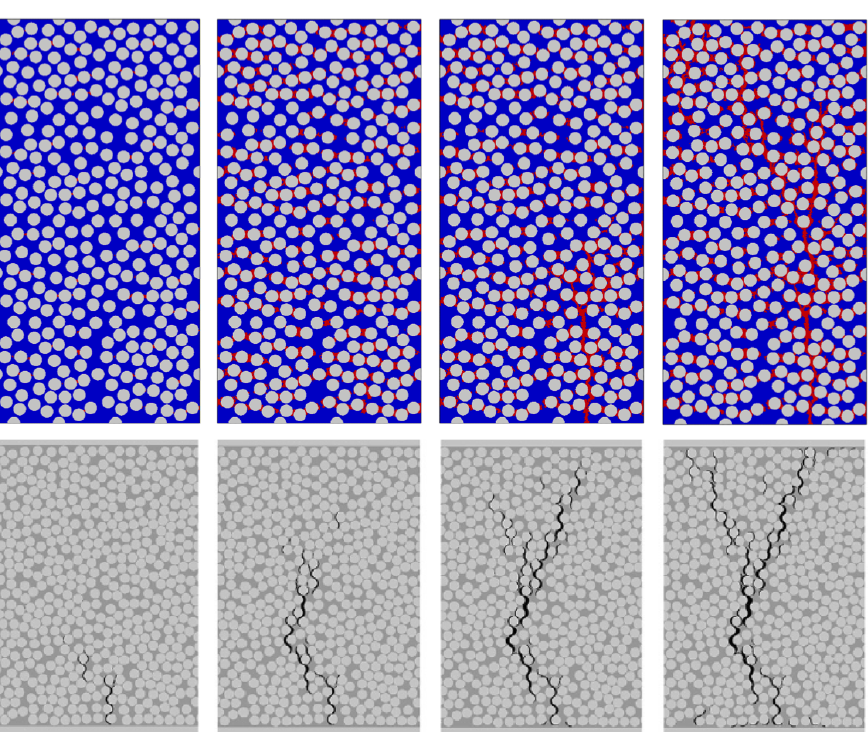
Figure 17. Qualitative comparison of two-piece matrix cracking from the present study ( top row ) with the computational study ( bottom row ) by Herráez et al. [19] on transverse cracking of an internal 90 ◦ layer inside a [0 2 /90 8 /0 2 ]